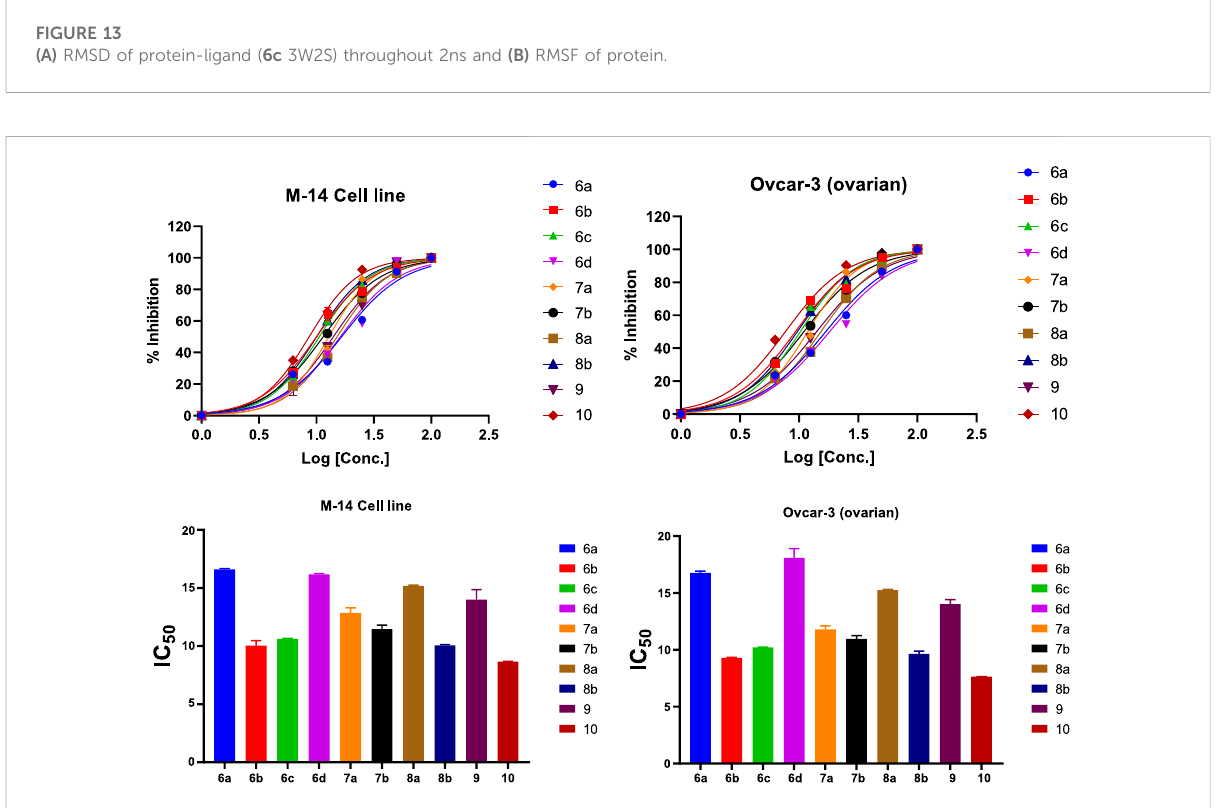
FIGURE 14 % of inhibition and IC 50 of selected compounds in DMSO solutions toward M-14 and Ovcar-3 cell lines.